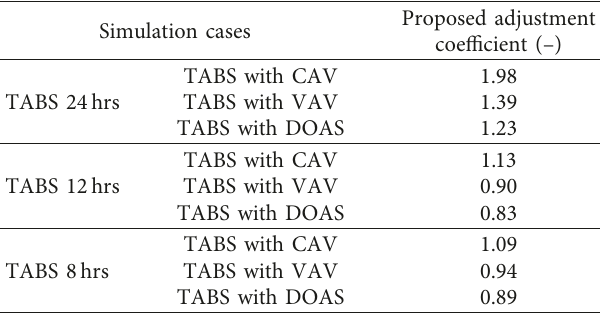
Table 3: Proposed adjustment coefficient of different air systems with different operation times.